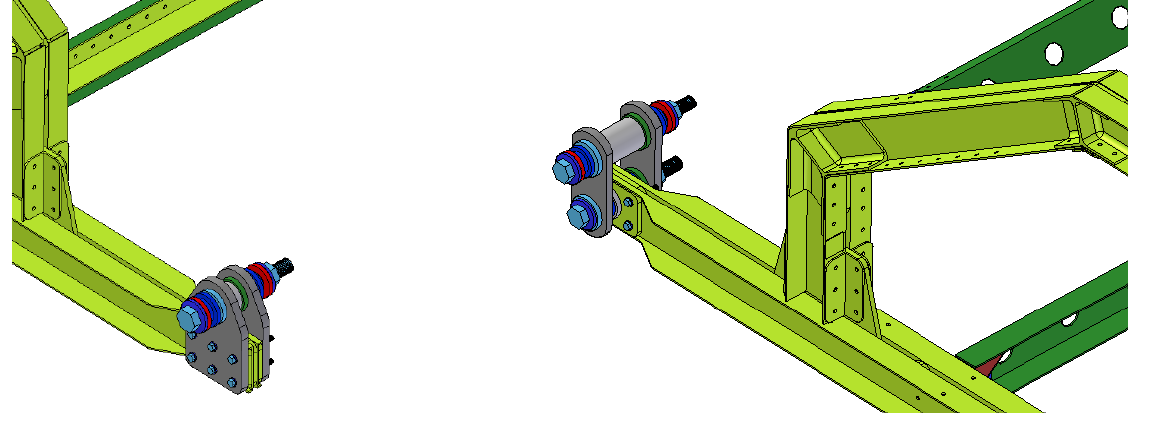
Figure 8: Simple cylindrical joint. Figure 9: Double cylindrical